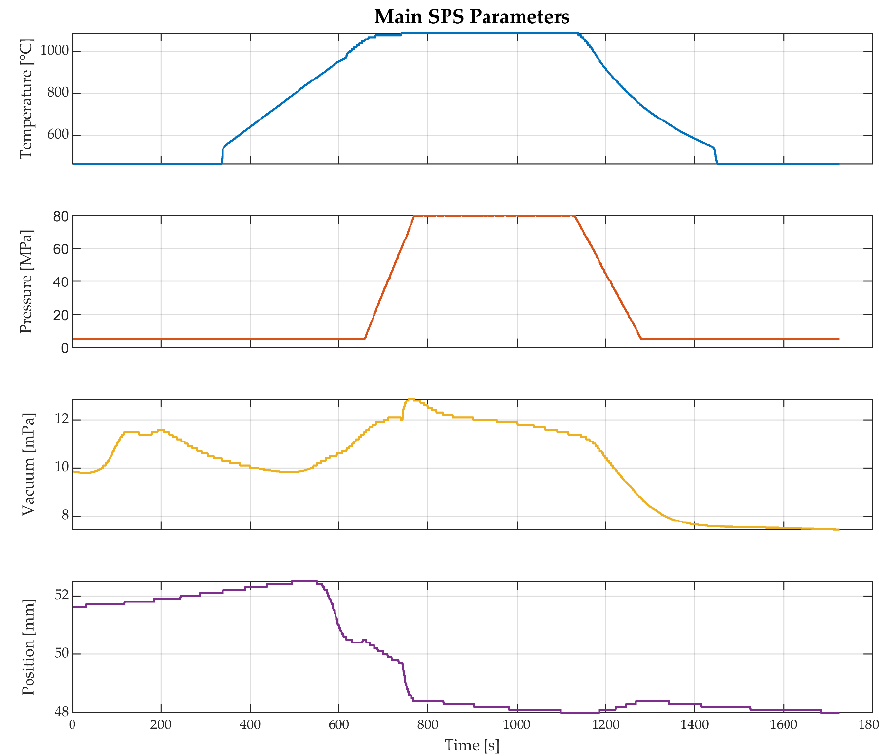
Ceramics 2021 , 4 FOR PEER REVIEW Figure 2. Typical evolution of main SPS parameters during processing. Figure 2. Typical evolution of main SPS parameters during processing.